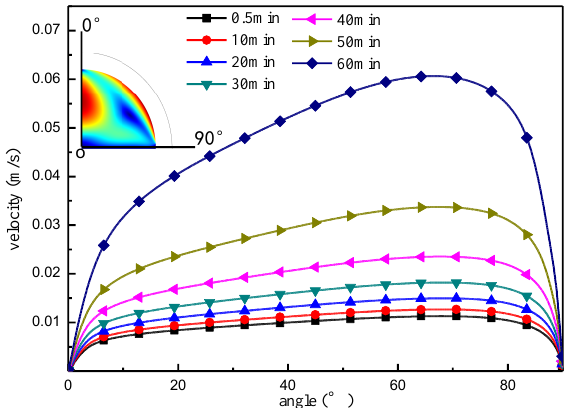
Figure 6. Droplet surface flow rate distribution.